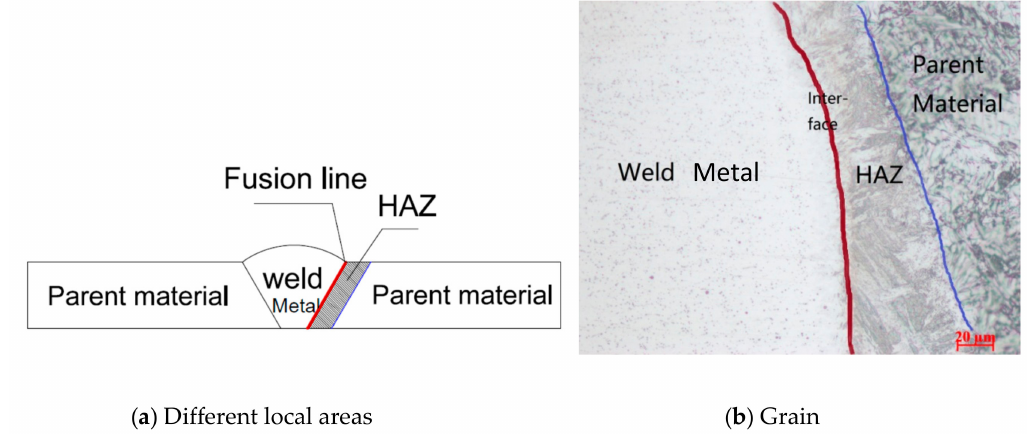
Figure 1. Di ff erent areas of the investigated welded joint. ( a ) Di ff erent local areas; ( b ) Grain.